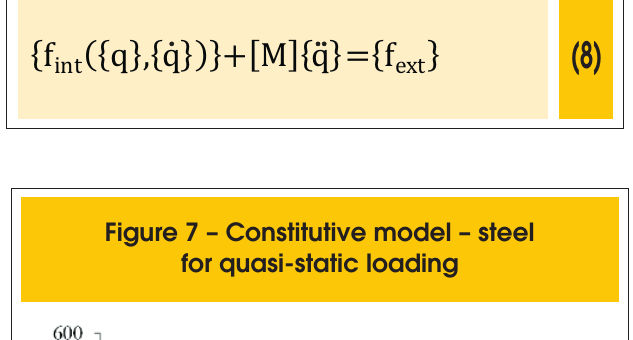
Figure 6 – Constitutive model – concrete in compression for quasi-static loading